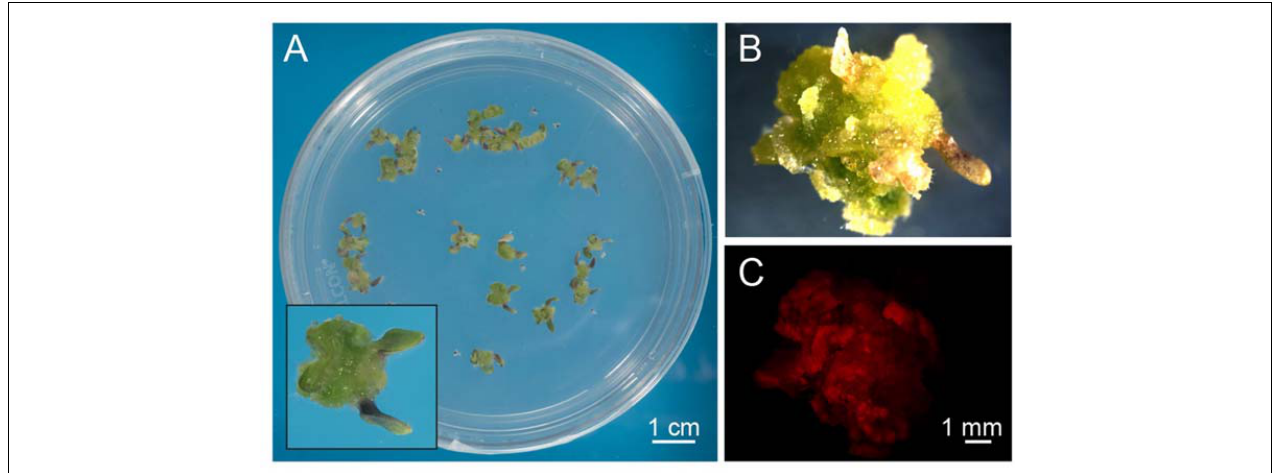
FIGURE 1 | Exogenous hormone-induced production of green calli from Arabidopsis seedlings. (A) Surface-sterilized seeds were plated on a cytokynin- and auxin-enriched agarized solid medium containing sucrose (MS, 0.8% agar, 3% sucrose, 0.25 µ g/ml BAP, 0.5 µ g/ml 2,4- D ) that had a delaying effect on seedling growth and development. Insert: magnification of a well-developed callus originating from the dedifferentiation and proliferation of hypocotyl cells after 3 weeks of germination. (B,C) Observations at the fluorescence stereomicroscope of green calli (B) , displaying red autofluorescence of chlorophyll when excited with blue light (C) .